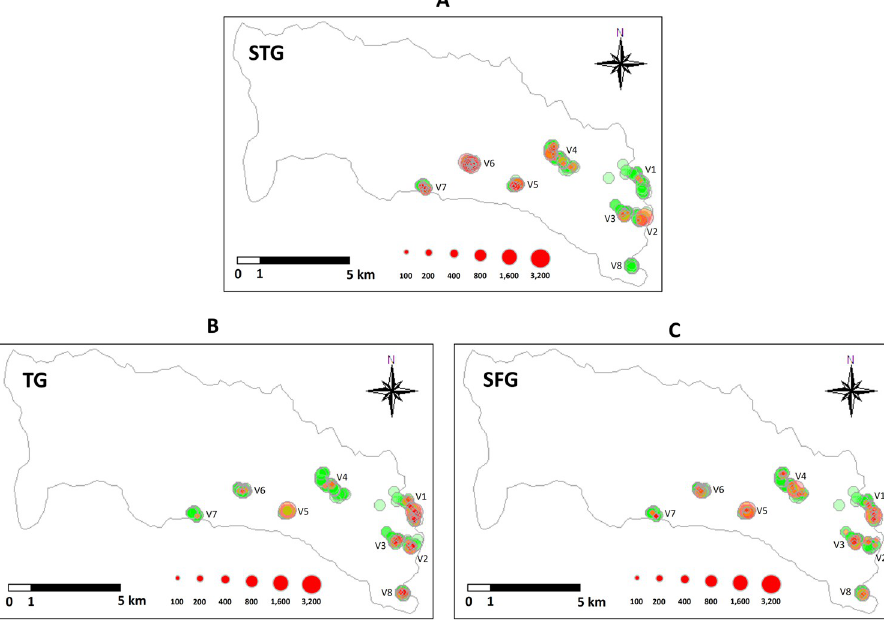
Fig 1. Distribution maps demonstrating the level of rickettsiosis exposures in participants from the eight villages in Saen Thong Subdistrict, Nan Province. Distribution and level of (A) STG, (B) TG and (C) SFG individual exposures from each village. Green circles indicate negativity. Red circles show positive exposures, and size of the circles indicate level of IgG IFA positivity at a diagnostic titer cut-off of 1:100.